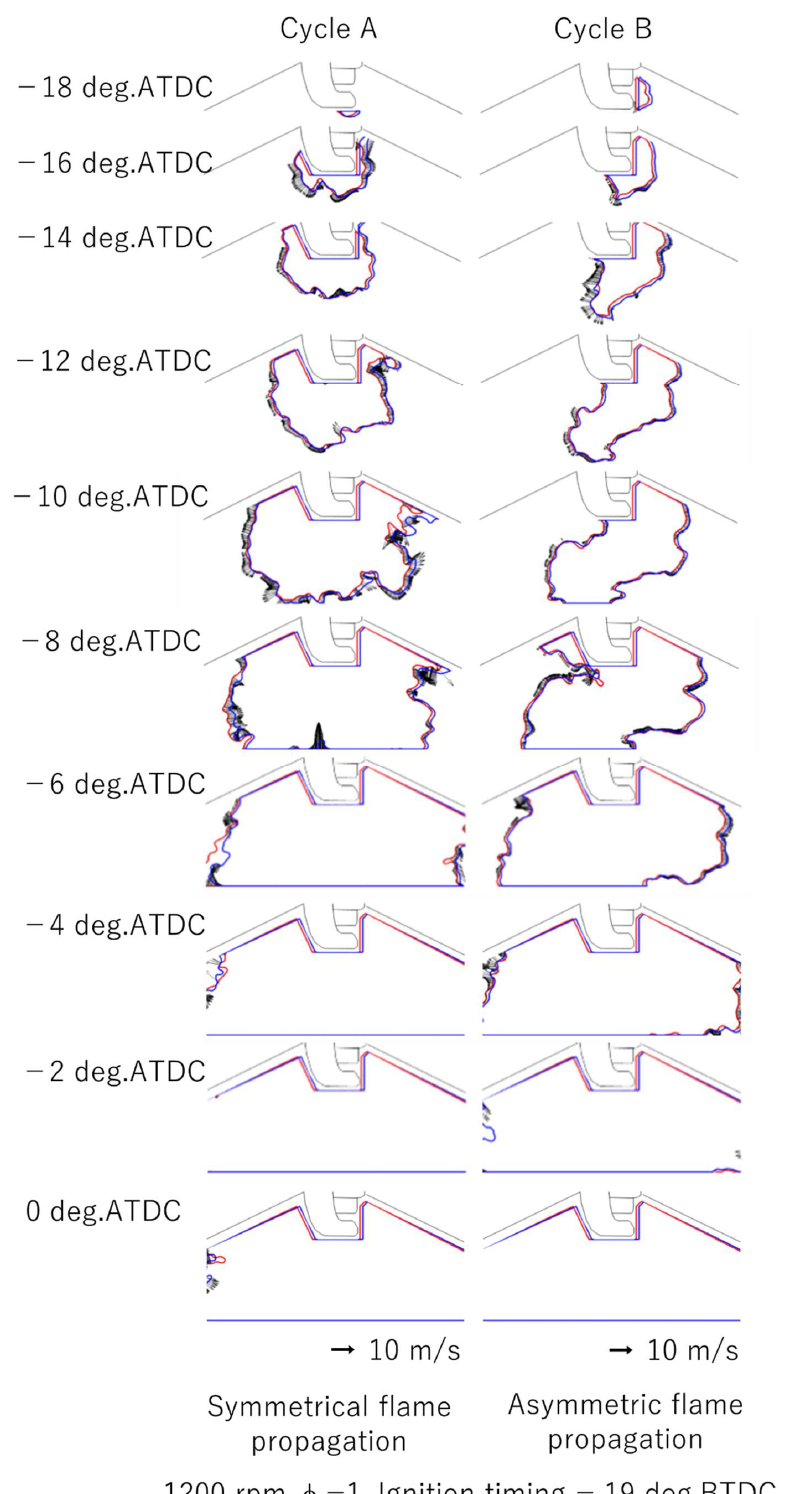
Figure 8. Flame front movement for different operating cycles.